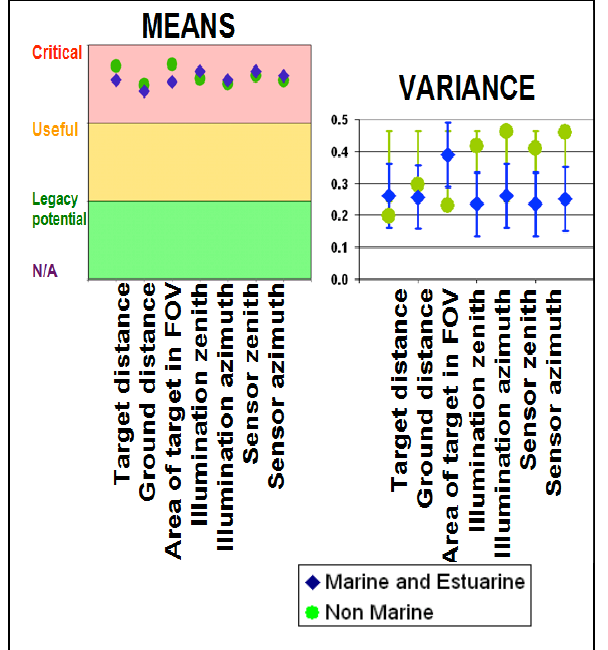
Figure 3.4 Group means and variances in ‘viewing geometry’ metadata category